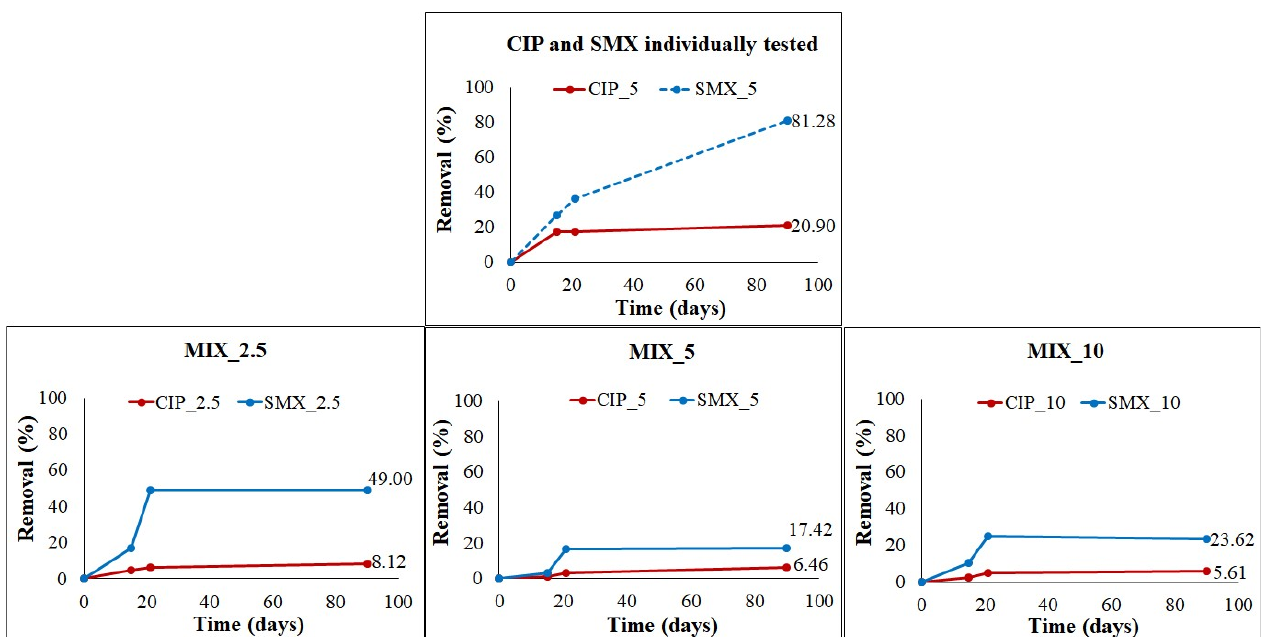
Figure 3. Antibiotics removal (%). Dotted line represents the results already published in a previous study [33]. study